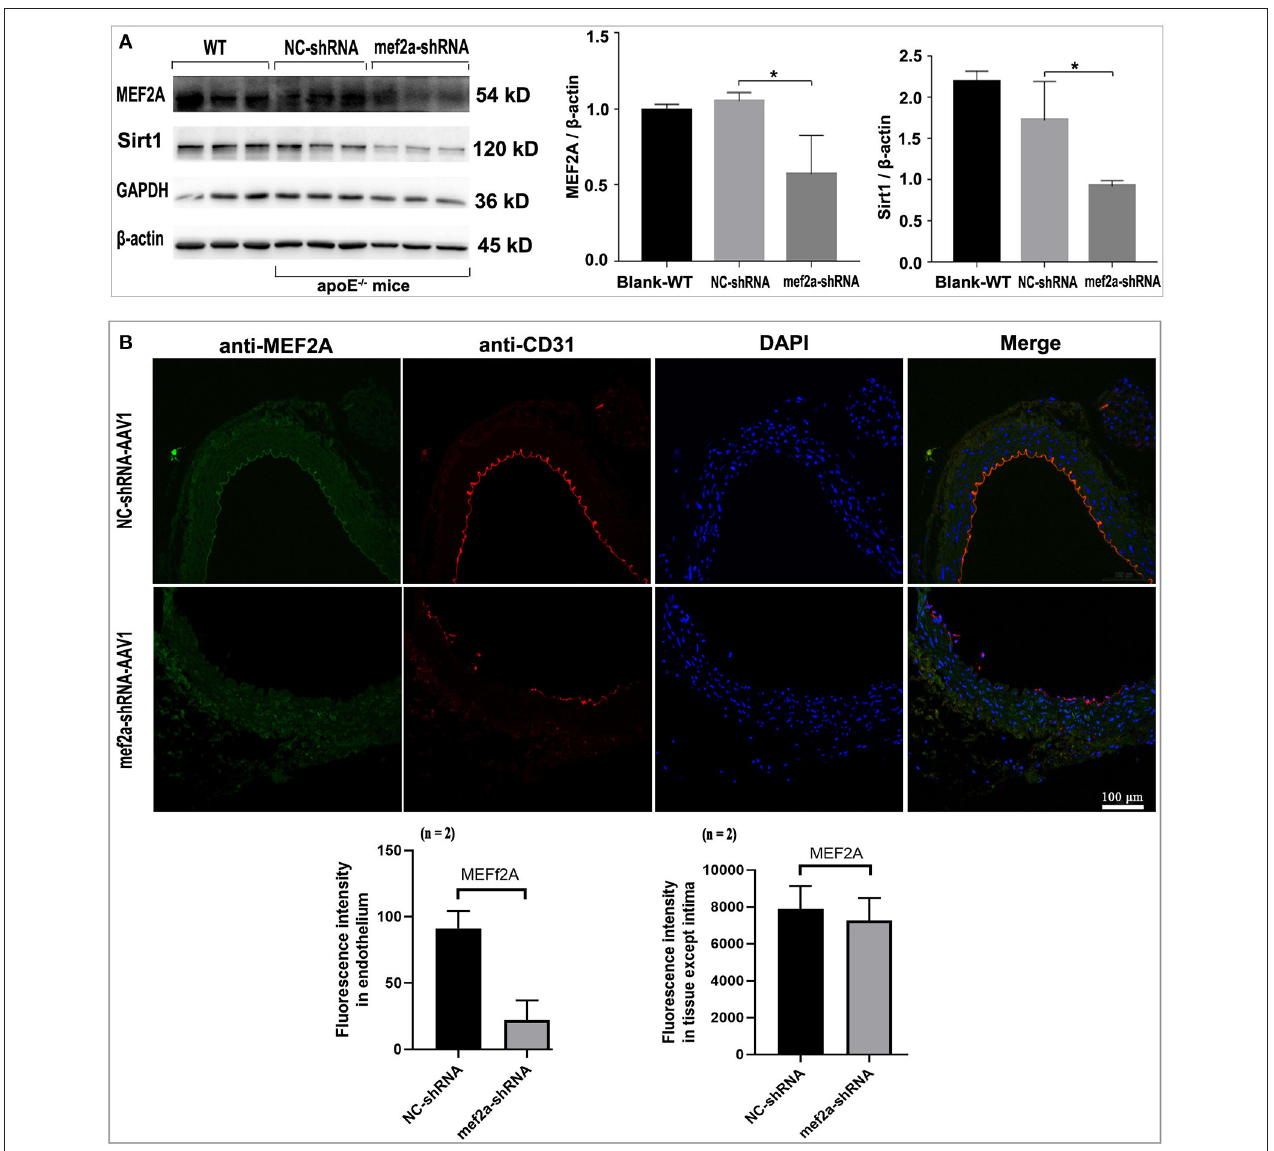
FIGURE 7 | Expression of MEF2A, SIRT1 and CD31 in the vessels of the mice. (A) Immunoblots of MEF2A and SIRT1. Mean ± SD is represented as bar plot. The statistical significance is analyzed by the unpaired Student’s two-tailed t -test. ns, no significance; * P < 0.05 between groups indicated. (B) Immunofluorescence of MEF2A and CD31 in the vascular endothelium. The cells expressed sufficient MEF2A were stained green, and the cells expressed sufficient CD31 were stained red. WT: wild type mice; The “n” indicates the sample